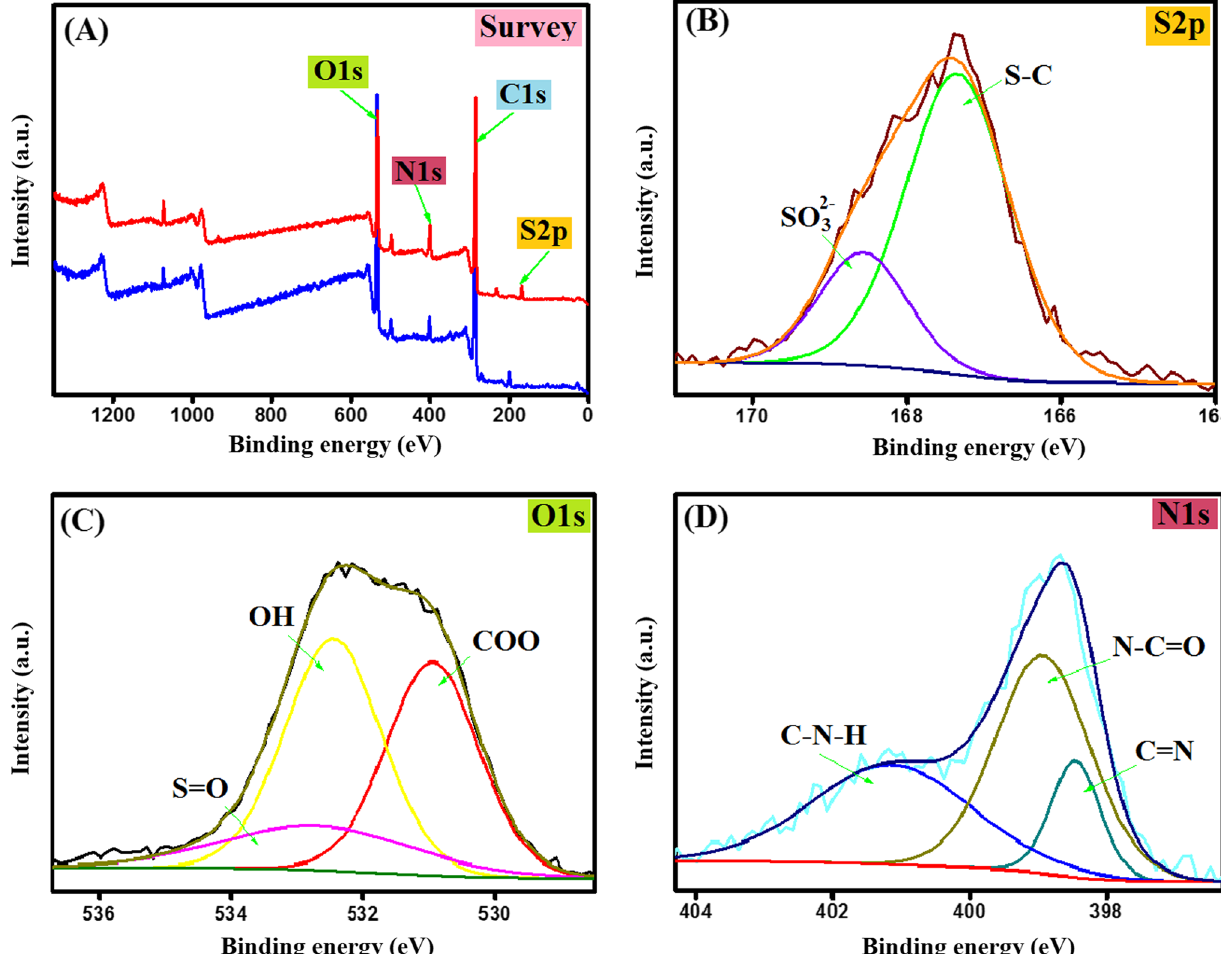
Fig. 7 A XPS survey of α -kGl-AmCsSB before and after the CR adsorption process, B S2p spectrum, C O1s spectrum and D N1s spectrum after the adsorption